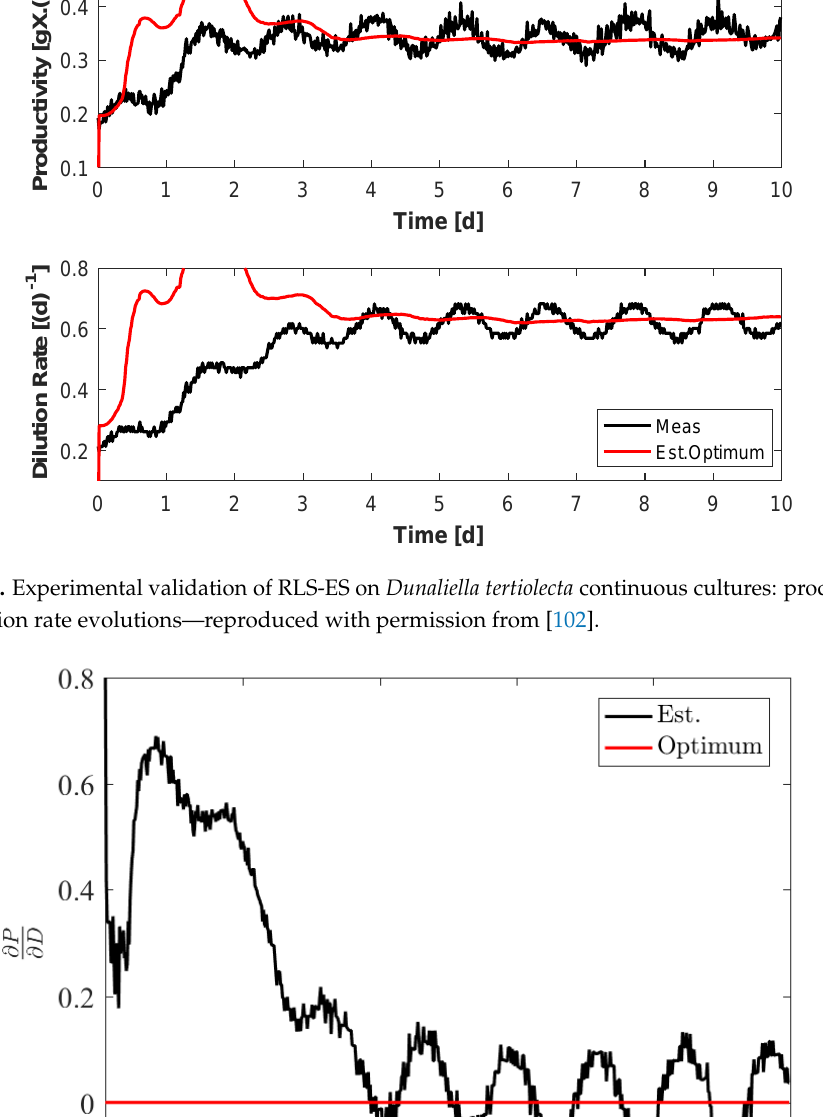
Figure 15. Experimental validation of RLS-ES on Dunaliella tertiolecta continuous cultures: productivity and dilution rate evolutions - reproduced with permission from [102]